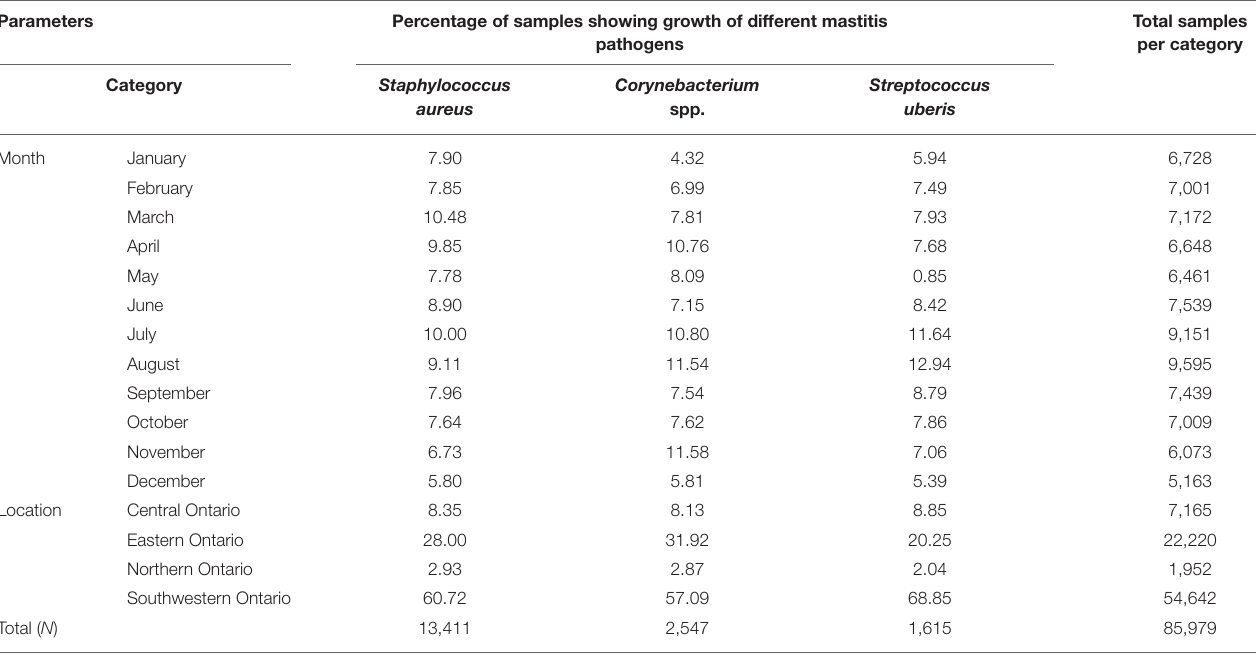
TABLE 3 | Temporal (monthly) and spatial change in the proportion of bovine milk samples positive for various mastitis pathogens between 2008 and 2017 in Ontario, Canada. Parameters